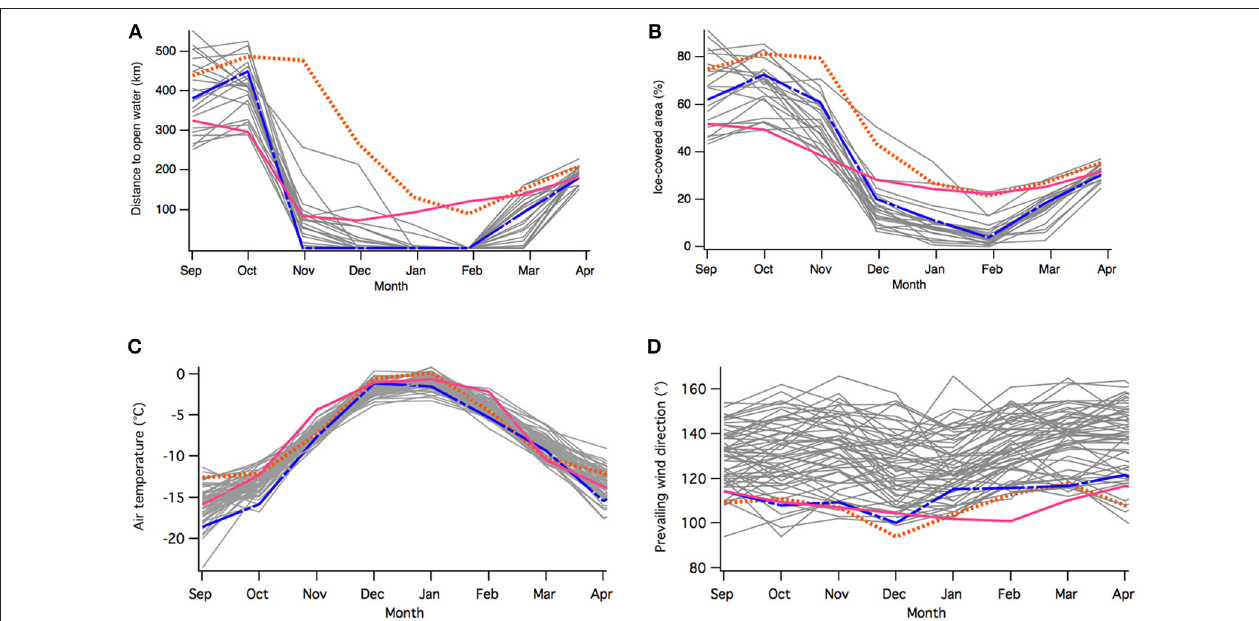
FIGURE 2 | Monthly distance to the nearest open water from the colony (A) and the percentage of ice-covered area between 135 and 145 ◦ E, and between 61 and 67 ◦ S from 1992 to 2017 (B) . Monthly average air temperature in ◦ C (C) and direction of prevailing winds in degrees from the north ( ◦ ) (D) observed at the Dumont d’Urville station for the years 1956–2017 (months on the x-axis). The years 2013–14, 2015–16, and 2016–17 are in orange, blue and magenta, respectively, while other years are in gray.